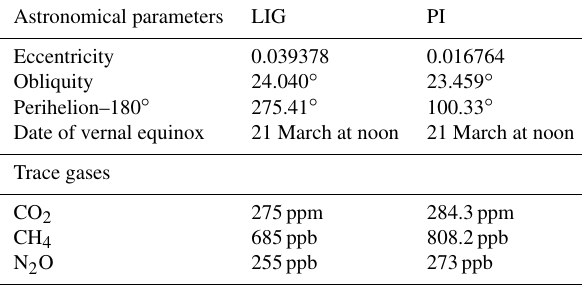
Table 1. Astronomical parameters and atmospheric trace gas con- centrations used to force LIG and PI simulations (from Otto- Bliesner et al.,